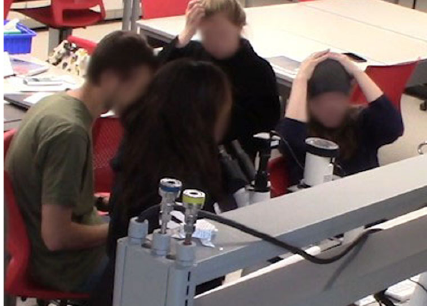
FIG. 3. Lisa expresses frustration and confusion while recog- nizing procedural